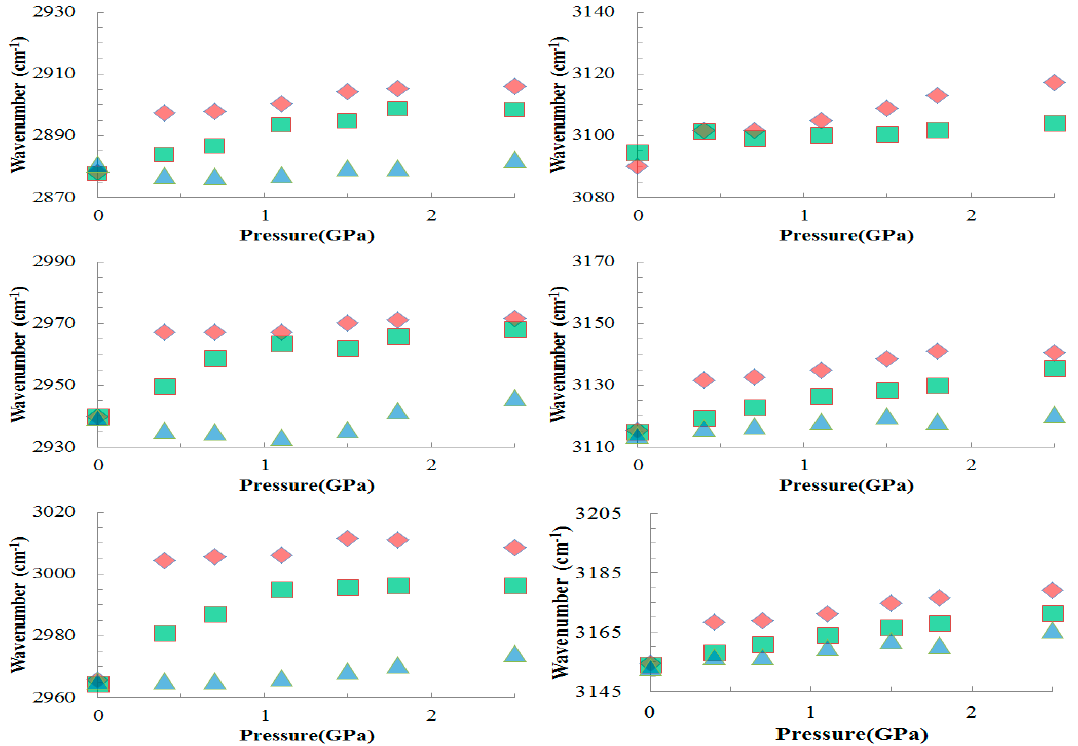
Figure 7. Pressure dependence of the C-H stretching frequencies of the [BMIM][TFS]/Al 2 O 3 mixture (diamonds), the mixture after two washes with ethanol (squares), and the mixture after five washes (triangles).